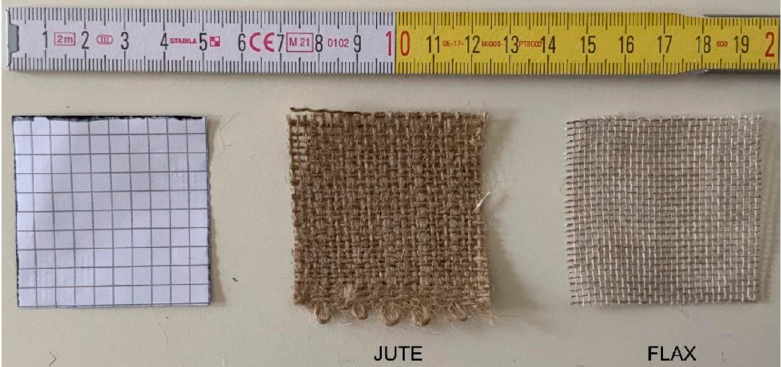
Figure 1. Fabric